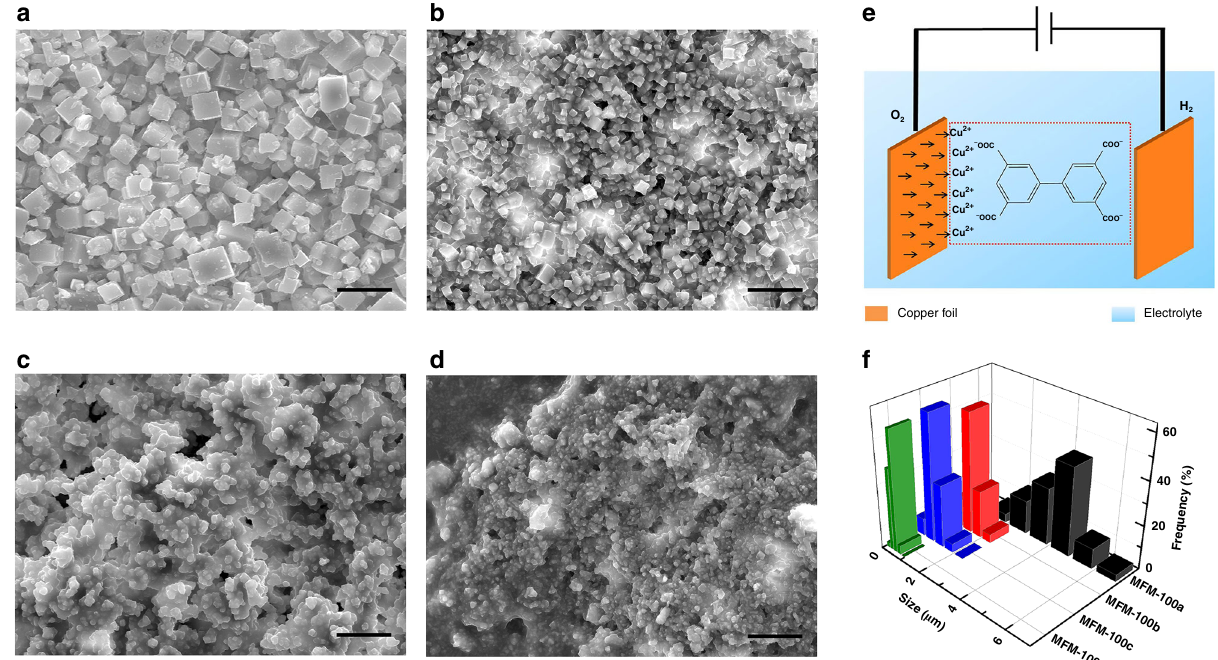
Fig. 1 SEM images and particle size distributions of MFM-100 samples. SEM image of MFM-100a ( a ), MFM-100b ( b ), MFM-100c ( c ) and MFM-100d ( d ). e Schematic diagram for the electrosynthesis of MFM-100. f Particle size distributions for samples of MFM-100. The scale bar in all SEM images is 10 μ m. The diameter of IL aggregates is 4 nm